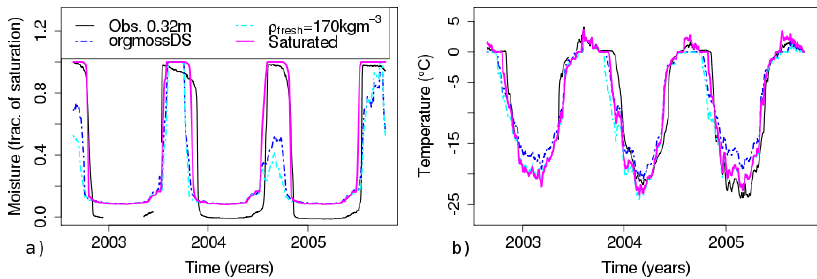
Figure 10. Simulated and observed (a) soil moisture and (b) temperatures at approximately 32cm depth. Unfrozen soil moisture is shown as a fraction of saturation. The three simulations show firstly the effect of increasing snow density (compare orgmossDS and ρ fresh = 170kgm − 3 ) and the effect of setting the soil moisture to saturated with increased organic matter (compare ρ fresh = 170kgm − 3 and Saturated ). Observations are from a polygon